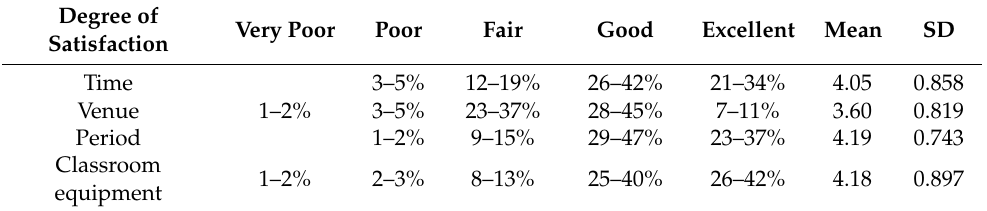
Table 7. Grouped total responses of budding journalists’ “spatial technical/logistical infrastructure”.